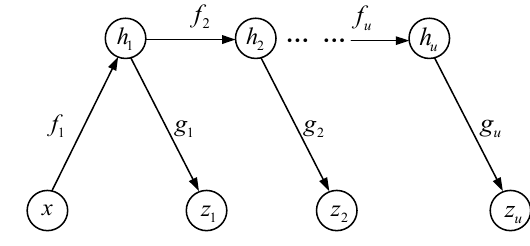
Figure 3. An S-SAE network structure.